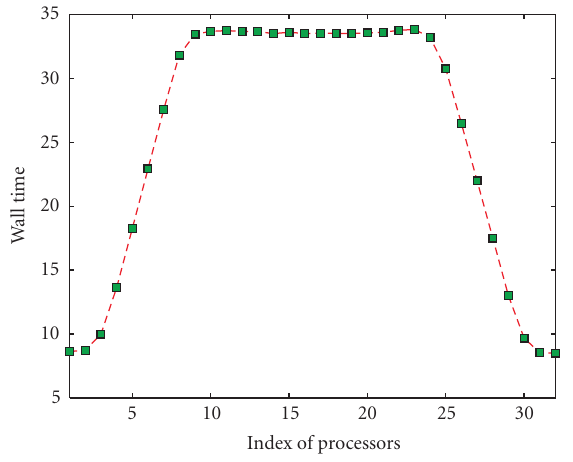
Figure 9: Wall time of each processor with the uniform partition of I . The graph looks like a trapezoid, exhibiting a problem of load im- balance. The processors in the middle bear higher load, while those on the two sides bear lower